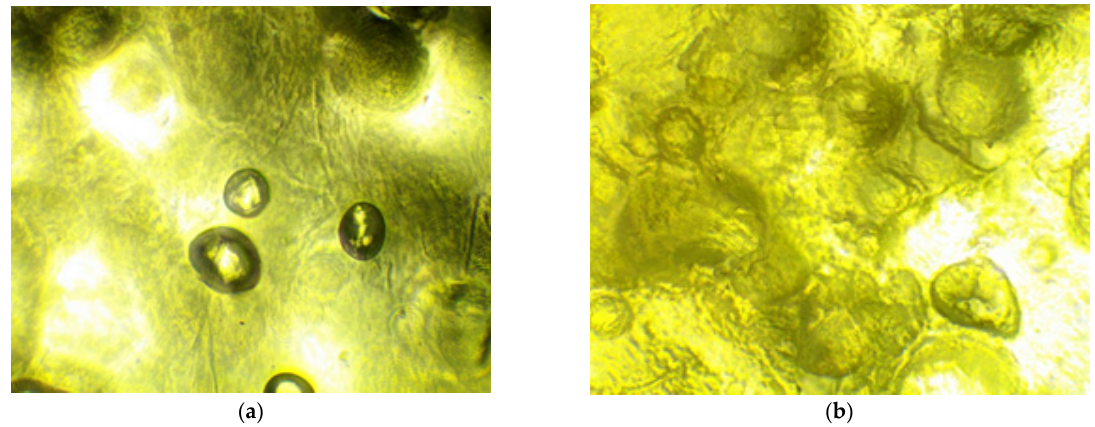
Figure 2. Initial microphotographs of the texture of the BIN composite “chitosan-silicon dioxide”: